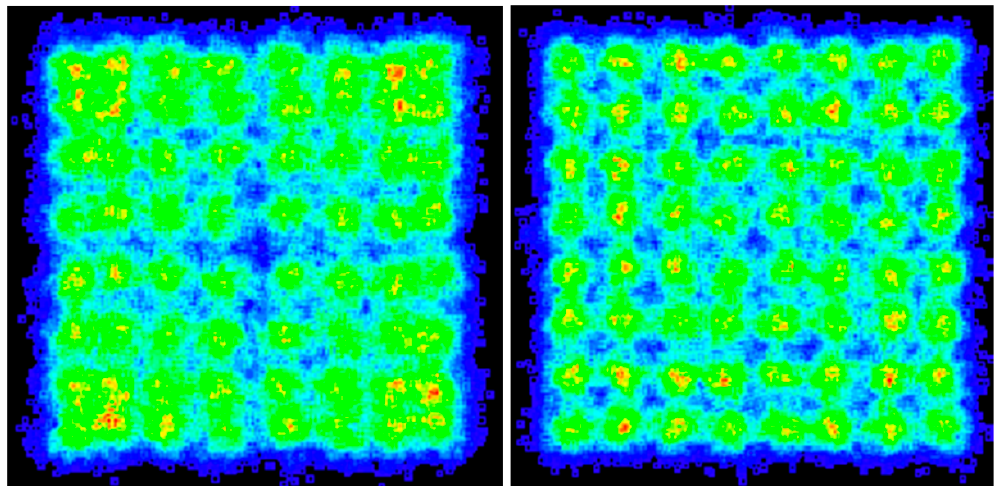
Figure 7. Constellation diagram without Volterra filter (left) and that with Volterra filter (right). Both results are obtained with bandwidth compensation and arcsin compensation.